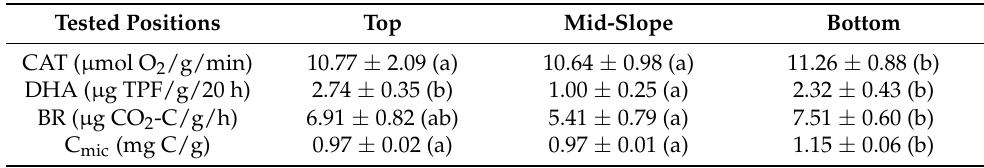
Table 2. Microbial parameters of soils collected along the topographical gradient of the forest gully: top, mid-slope, and bottom (average values ± sd; n = 3; the same letter indicates no significant difference; ANOVA, Tukey HSD test, p <